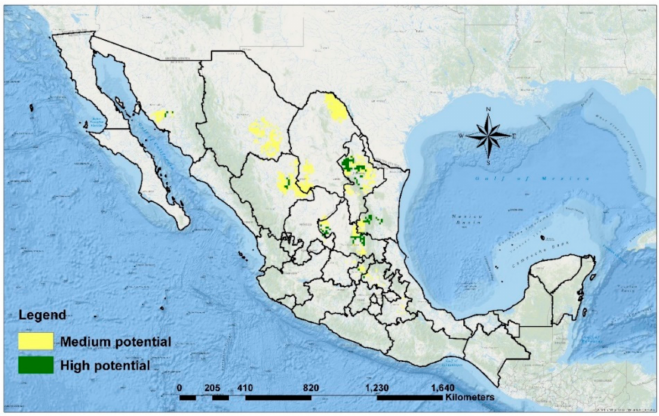
Figure 7. Distance to gas stations, power generation plants and transportation infrastructure in high potential and medium potential areas, distance less than 30 km in scenario